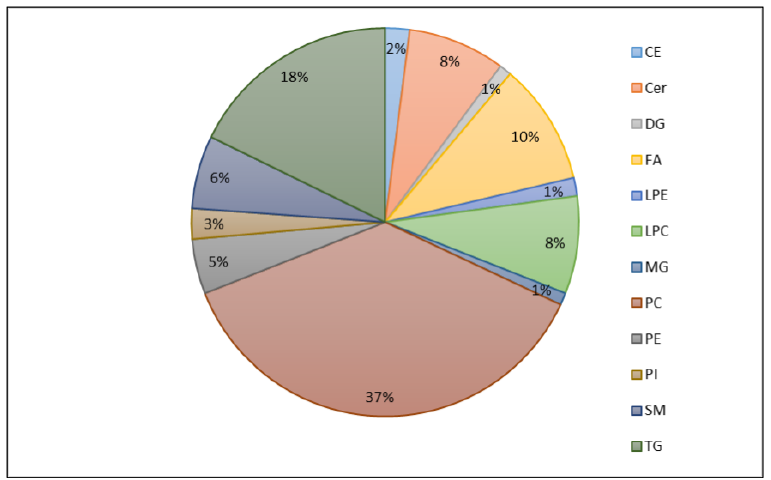
Figure 2. Lipid families identified from untargeted lipidomic analysis and identification by